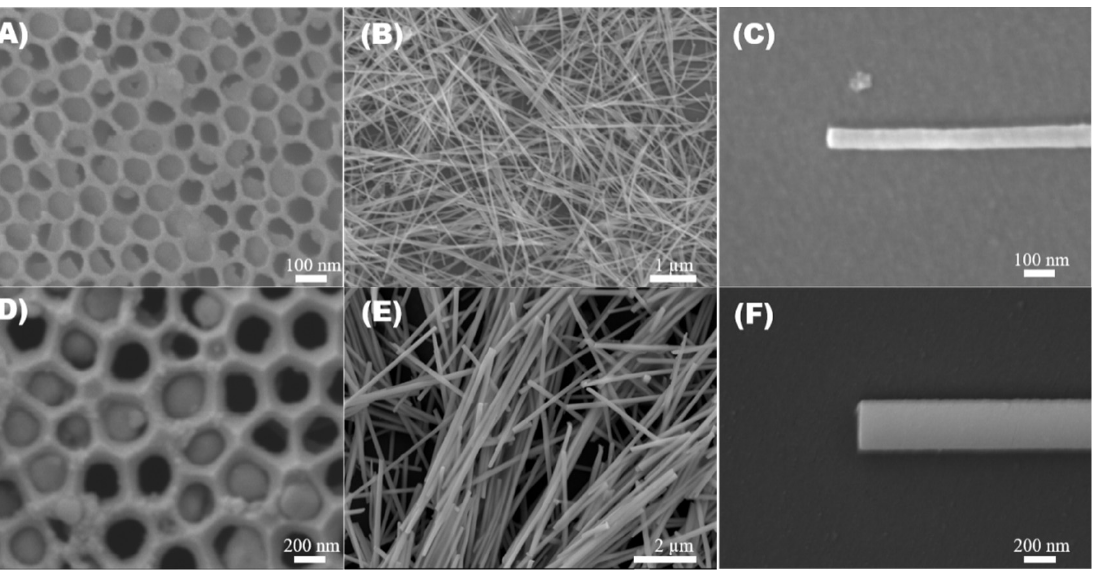
Figure 3. FE ‐ SEM images of InSb embedded over the oxalic and phosphoric AAO template using the vacuum die casting process ( A , D ), InSb nanowires synthesized using the oxalic AAO template ( B , C ) and InSb nanowires synthesized using the phosphoric AAO template ( E , F ). The morphology and crystal structure of synthesized InSb NWs were examined by TEM. Figure 4A,D depicts the typical TEM images of single InSb O ‐ NW and InSb P ‐ NW. The corresponding SAED pattern marked in Figure 4B,E reveals the polycrystalline nature of the InSb O ‐ NW and InSb P ‐ NW. The obtained lattice fringes of 0.33 and 0.36 nm correspond to the (200) and (111) planes for InSb O ‐ NW and 0.24 and 0.20 nm oriented in (220) and (311) planes for P ‐ NW explicit the zinc ‐ blende crystal phase [30,31]. The obtained re ‐ sults confirm that the growth of InSb NWs was preferentially oriented along the zone axis (Figure 4C,F).